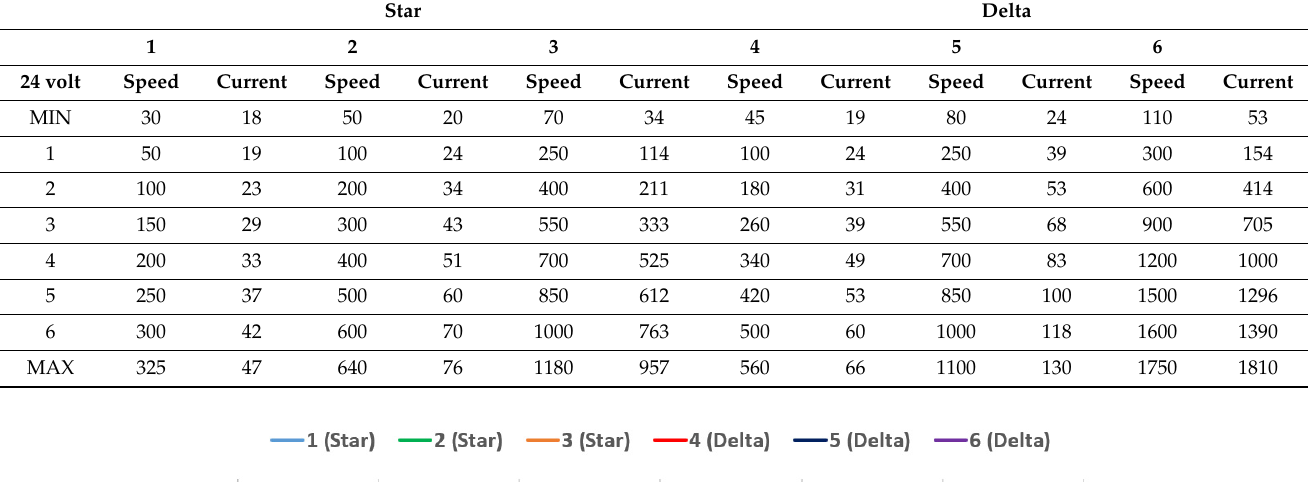
Table 1. Dependency of RPM on the stator windings configuration and operating current.